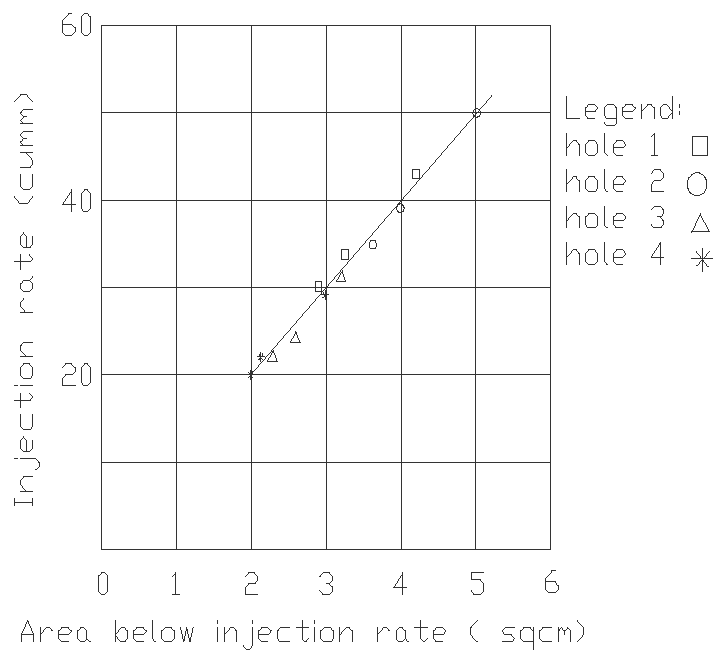
Figure 7. Linearity chart for individual injection